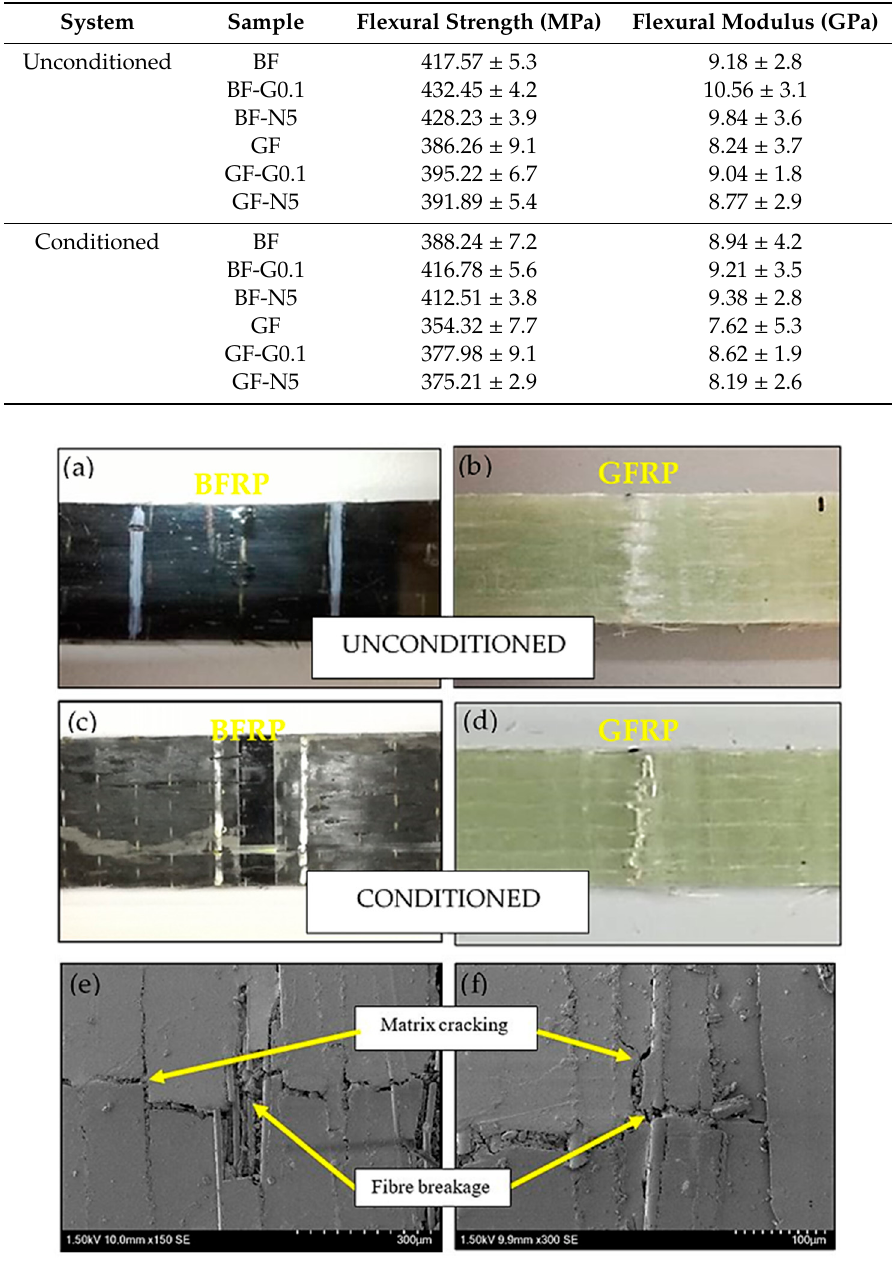
Figure 9. Fractured specimens of unmodified composite under three-point bending, where ( a , b ) unconditioned, ( c , d ) conditioned and, ( e , f ) SEM micrographs of the damaged specimens.